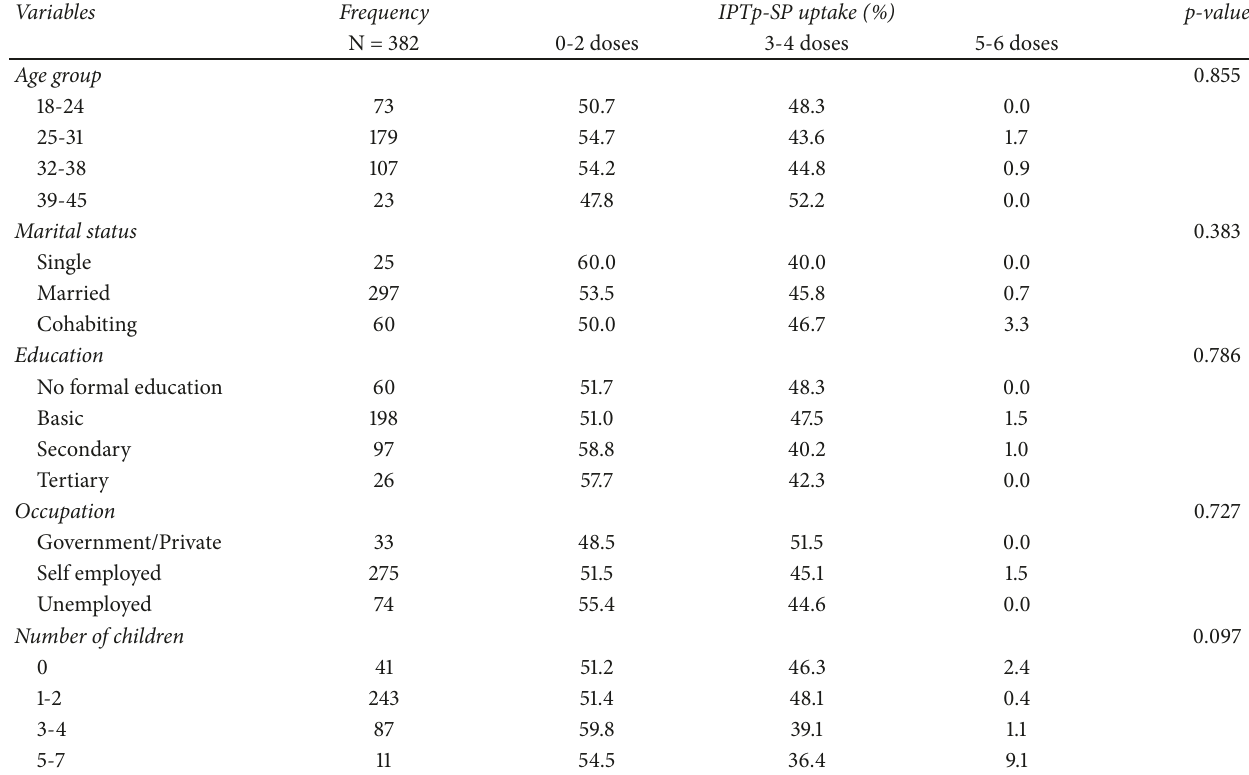
Table 2: Sociodemographic characteristics of participants and IPTp-SP